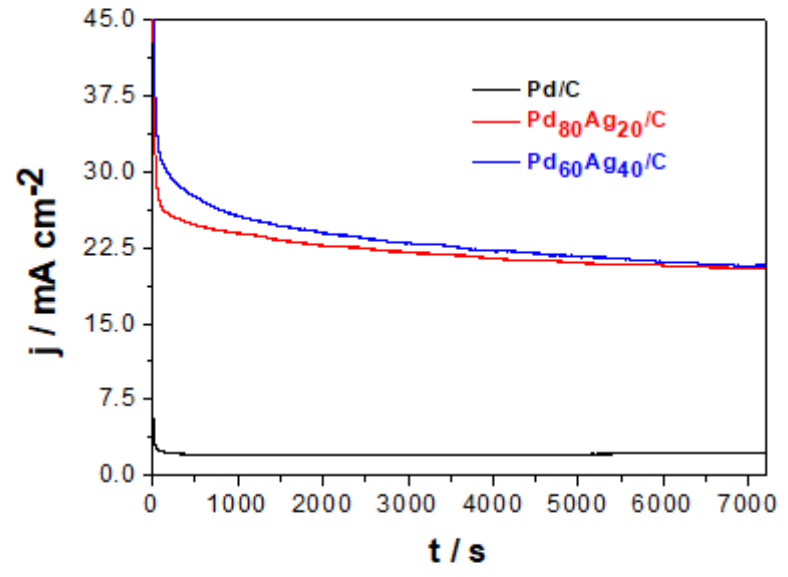
Figure 5. Chronoamperometry curves of the electrocatalysts 40% Pd-based/C in N 2 -purged KOH 1.0 mol L − 1 /ethanol electrolyte at − 0.4 V vs.